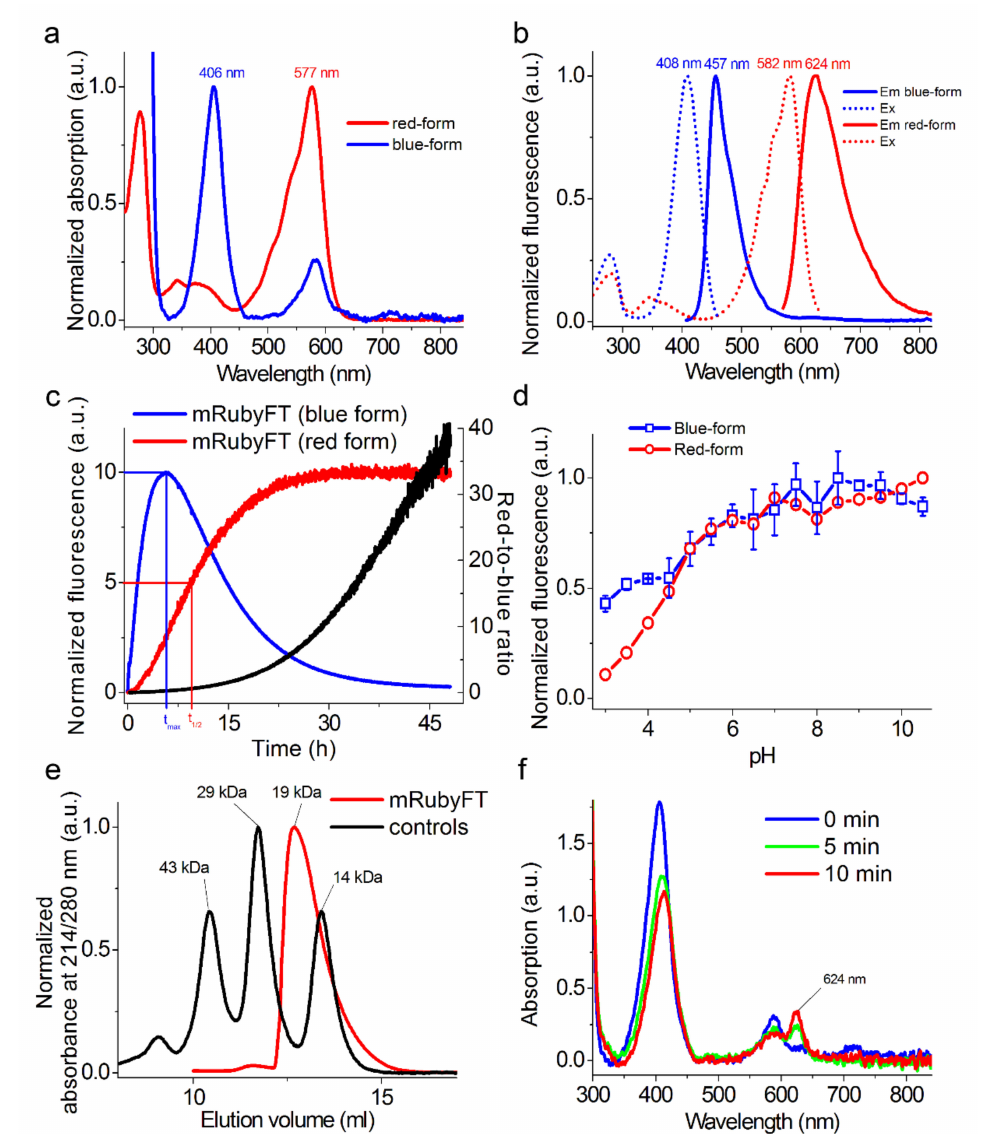
Figure 2. In vitro properties of the purified mRubyFT protein. ( a ) Absorption spectra for blue and red forms of mRubyFT protein in PBS buffer at pH 7.40. ( b ) Excitation and emission spectra for blue and red forms of mRubyFT in PBS buffer at pH 7.40. ( c ) Maturation of blue and red forms for mRubyFT in PBS buffer at pH 7.40, 37 ◦ C. Red-to-blue ratio was calculated according to the red and blue fluorescence time dependences normalized to 100. ( d ) Fluorescence intensity for blue and red forms of mRubyFT as a function of pH. Three replicates were averaged for analysis. Error bars represent the standard deviation. ( e ) Fast protein liquid chromatography of mRubyFT protein. mRubyFT was eluted in 20 mM Tris-HCl (pH 7.80) and 200 mM NaCl buffer. The molecular weight of mRubyFT was calculated from a linear regression of the dependence of logarithm of control molecular weights vs. elution volume (Figure S4). ( f ) Changes in absorption spectrum of the purified mRubyFT in PBS buffer, pH 7.4 as a result of illumination with 405 nm LED array (57 mW/cm 2 ) for the indicated